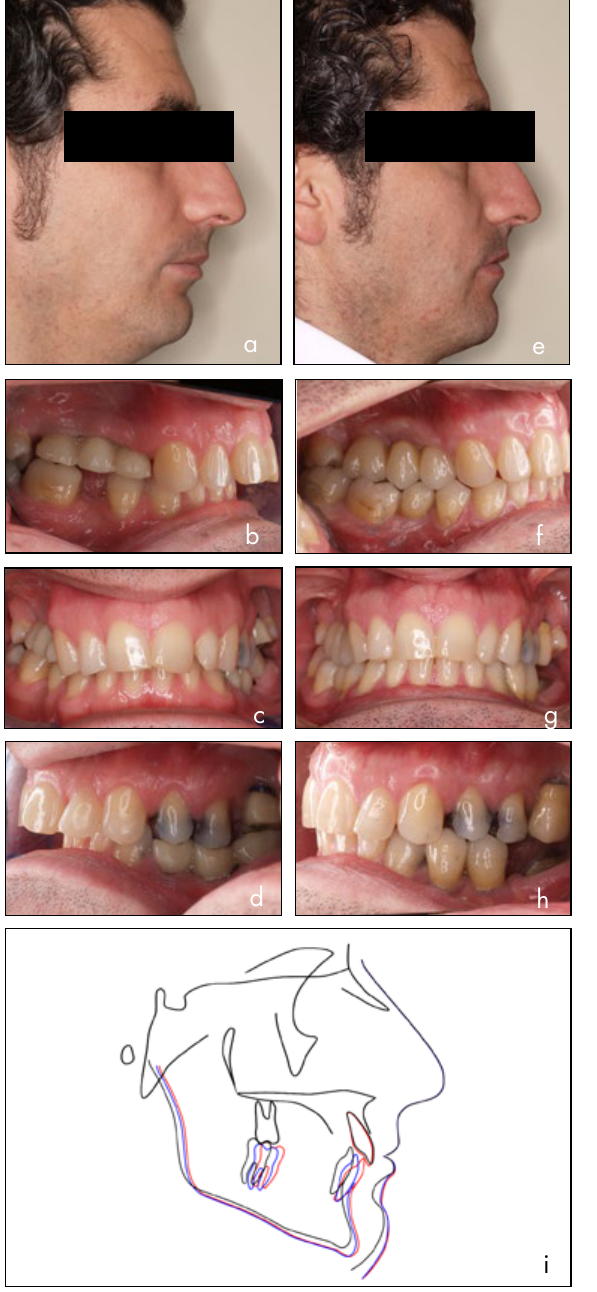
Figure 4. (a–d) A thirty-seven-year-old patient before treatment. The patient had crowns on implants with uneven vertical heights leading to a canted occlusal plane. There was a full unit Class II relationship with a large overjet due to a retruded mandible. (e–h) A 4 mm anterior repositioning of the mandible increased the height of the lower face. During orthodontic treatment the lower incisors were proclined and the space between the upper right premolar and canine was closed. Treatment lasted 14 months, and radiographs two years following mandibular repositioning indicated that the profile had greatly improved, overjet was normal and the canine relations were Class I. Replacement of the left lower molar with an implant is planned. (i) The superimposition of the tracing at T0 (black), T1 (blue) and T2 (red). The proclination of the lower incisors has changed lip function and allowed for the mandible to be displaced further anteriorly.